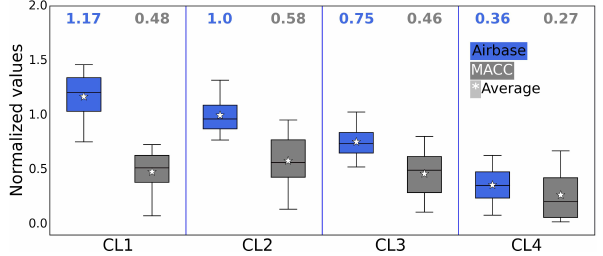
Figure 18. Percentiles (5–25–50–75–95) of ozone diurnal ampli- tudes in clusters; Airbase vs. MACC, second CA. Upper values in- dicate the mean seasonal amplitude of each cluster.